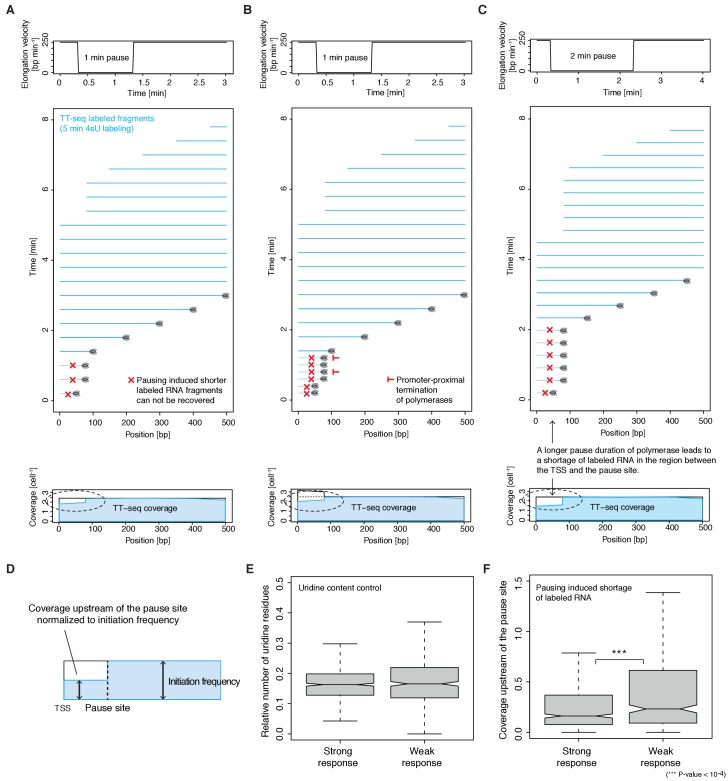
A longer pause duration but not promoter-proximal termination of polymerase leads to shortage of labeled RNA in the region between TSS and pause site.(A) Simulation of labeled RNA fragments synthesized in 5 min labeling duration (TT-seq fragments depicted for polymerases with a distance corresponding to 40 s of elongation, middle panel) for a pause site 80 bp downstream of the TSS with a given elongation velocity profile [bp min−1] comprising a pause duration of 1 min (upper panel) and a initiation frequency of 0.5 [cell−1min−1]. Lower panel shows the resulting TT-seq coverage. Shorter fragments have a higher probability to escape labeled RNA purification and can not be recovered fully. (B) Simulation of labeled RNA fragments as in (A) with two times the initiation frequency (1 [cell−1min−1]) and a promoter-proximal termination of every second polymerase. The resulting TT-seq coverage (lower panel) shows less effect (higher coverage) upstream of the pause site. For reasons of simplicity the promoter-proximal termination of every second polymerase is modeled by overlaying two simulation instances with an initiation frequency of 0.5 [cell−1min−1]. One as in (A) and one with a constantly terminating polymerase. Note that polymerases that terminate in the pause window do not contribute signal to the region downstream of the pause site. (C) Simulation of labeled RNA fragments as in (A) with a pause duration of 2 min (upper panel) leading to a greater shortage of labeled RNA in the region between the TSS and the pause site. (D) Schematic representation of coverage ratio calculation for real TT-seq coverage. (E) Distributions of gene-wise uridine content in the region between the TSS and the pause site for TUs with a response ratio >75% quantile (603 TUs) and TUs with a response ratio <25% quantile (527 TUs). (F) Distributions of gene-wise mean real TT-seq signal in the region between the TSS and the pause site normalized to initiation frequency for subsets as in (E).